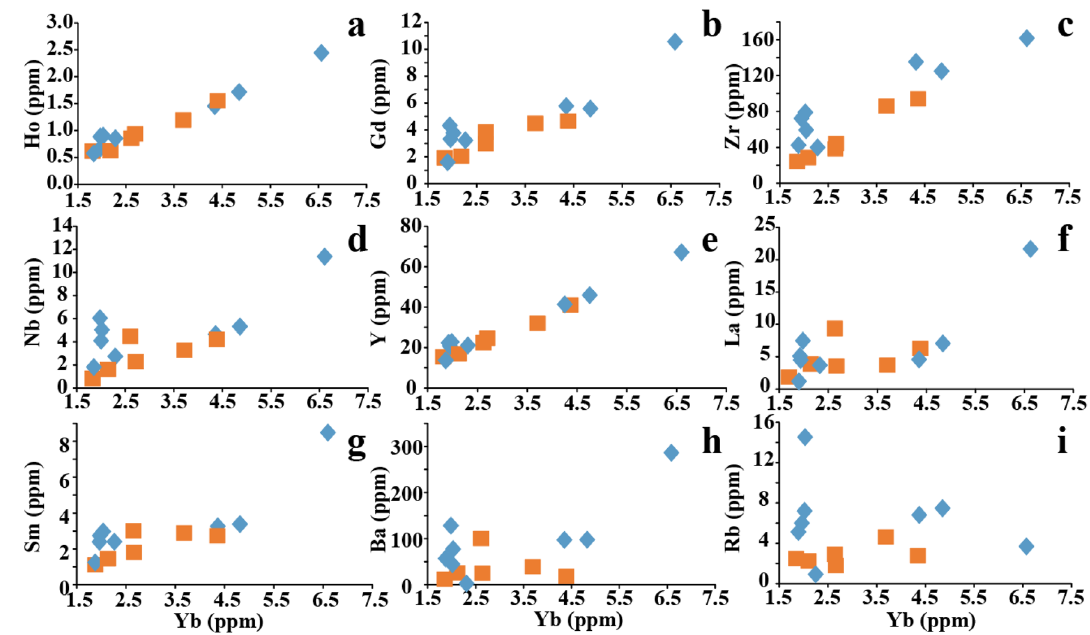
Fig. 10 Binary diagrams showing the trace element composition of the meta-mafic rocks samples. Symbols are the same as in Fig.